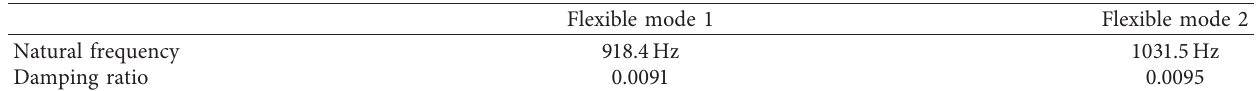
Table 2: The special choices of W